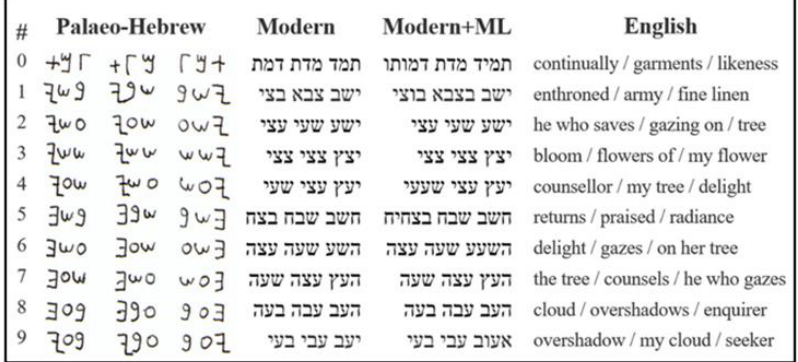
Figure 2. “Menorah” page from a Lead Book. Image (left) courtesy of Jean-Paul Bragard. Tracing (right) by Margaret Barker. See Supplementary Materials for more information.